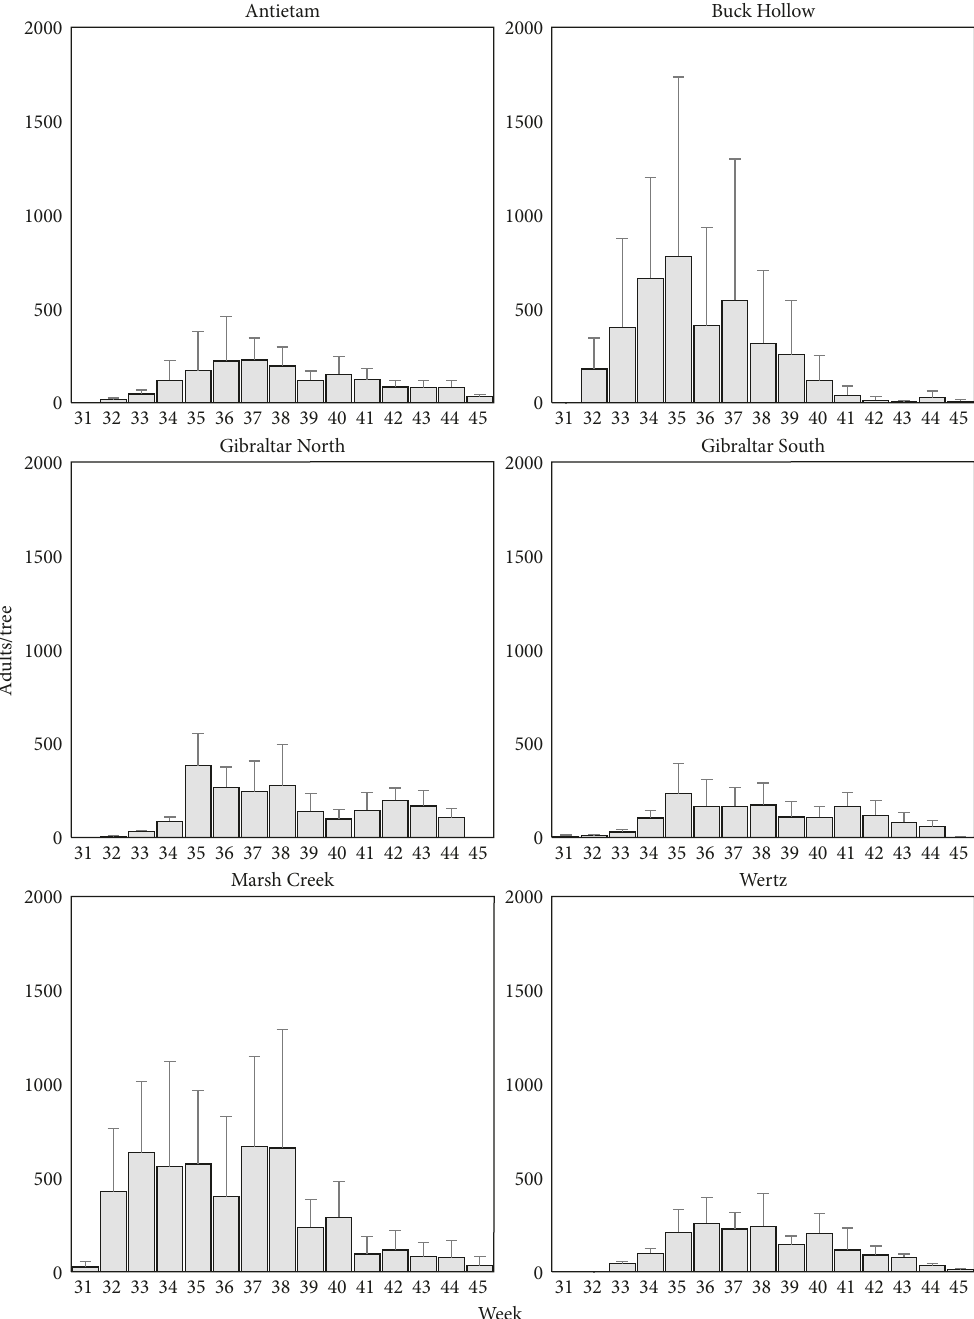
Figure 5: Seasonal dynamics of Lycorma delicatula adult count at different study